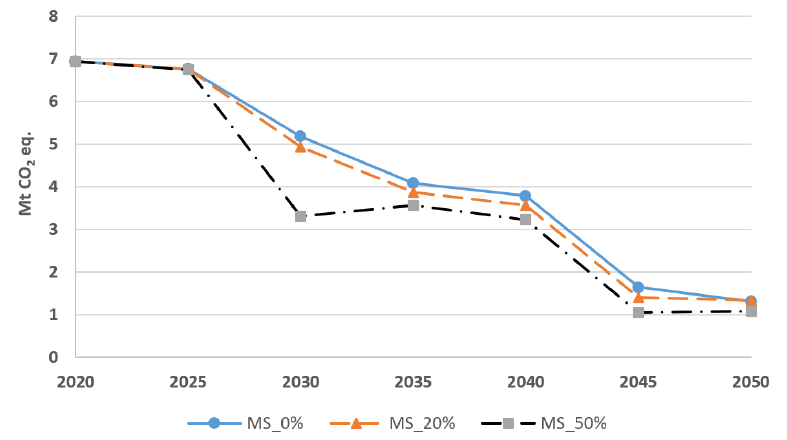
Figure 10. GHG emissions from the transportation sector for different modal shifts in BAU, as the mobility demand is partially shifted from light-duty vehicles to public transportation.